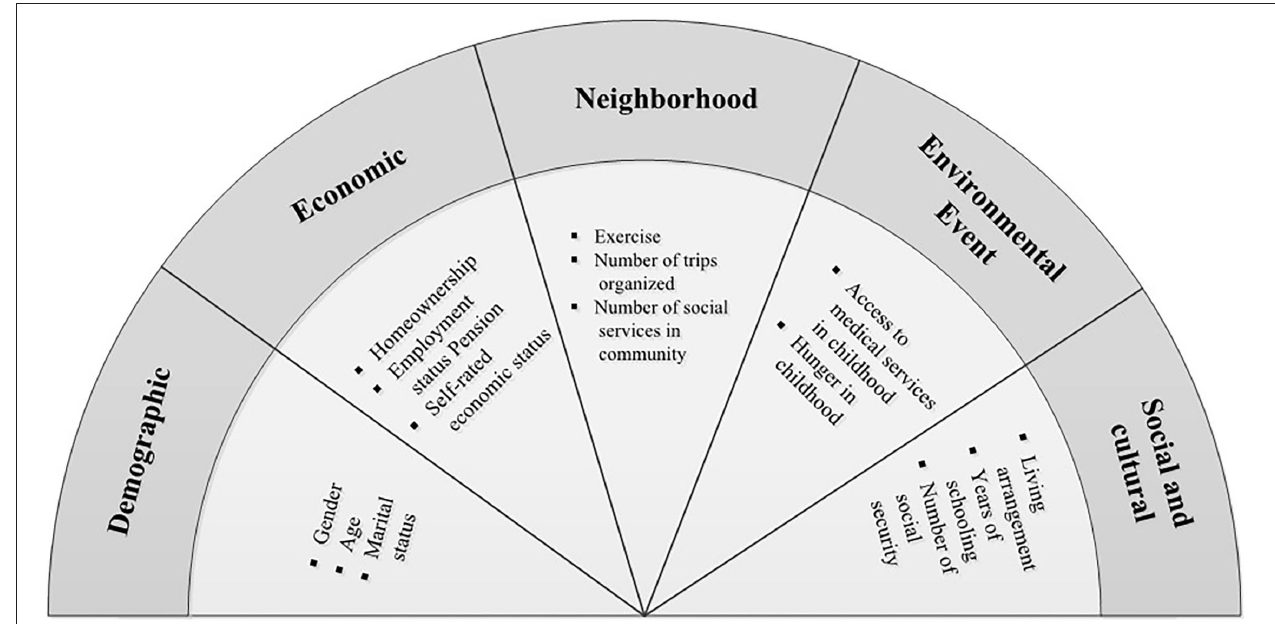
FIGURE 1 | Variable construction by domain based on Lund’s conceptual